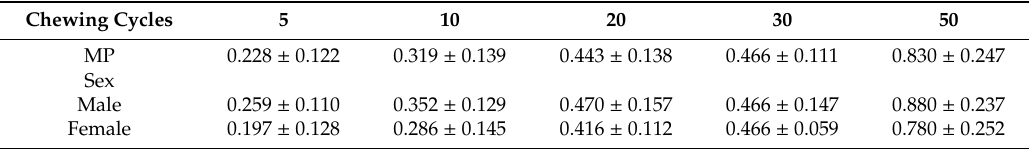
Table 2. Masticatory performance (MP) values according to the number of chewing cycles. The results are expressed as the mean and standard deviation